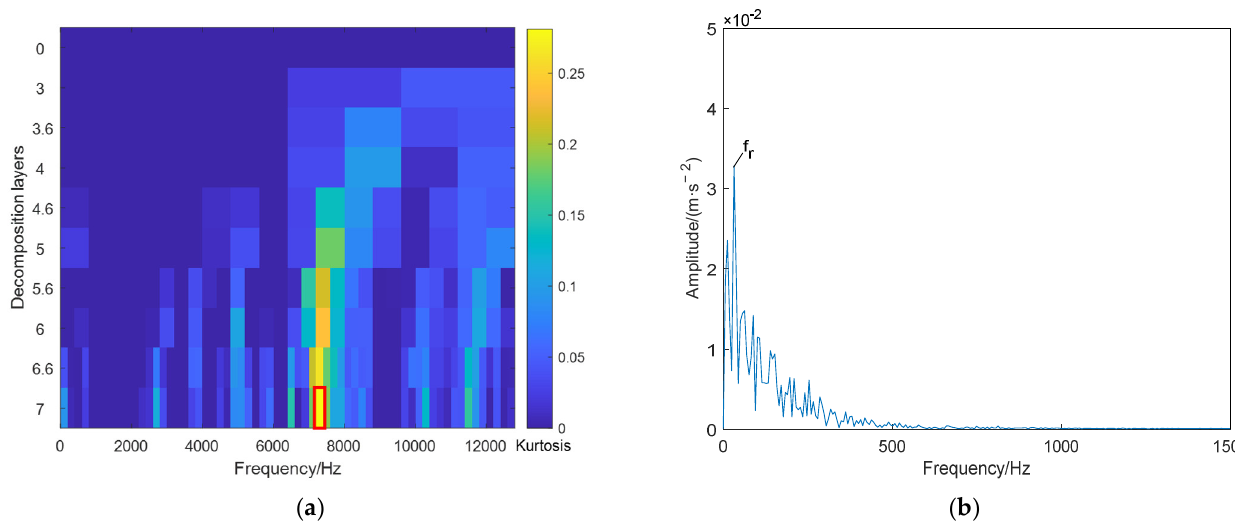
Figure 28. Fault signal FSK analysis results: ( a ) spectral kurtosis plot; ( b ) filtered envelope spectro- gram.